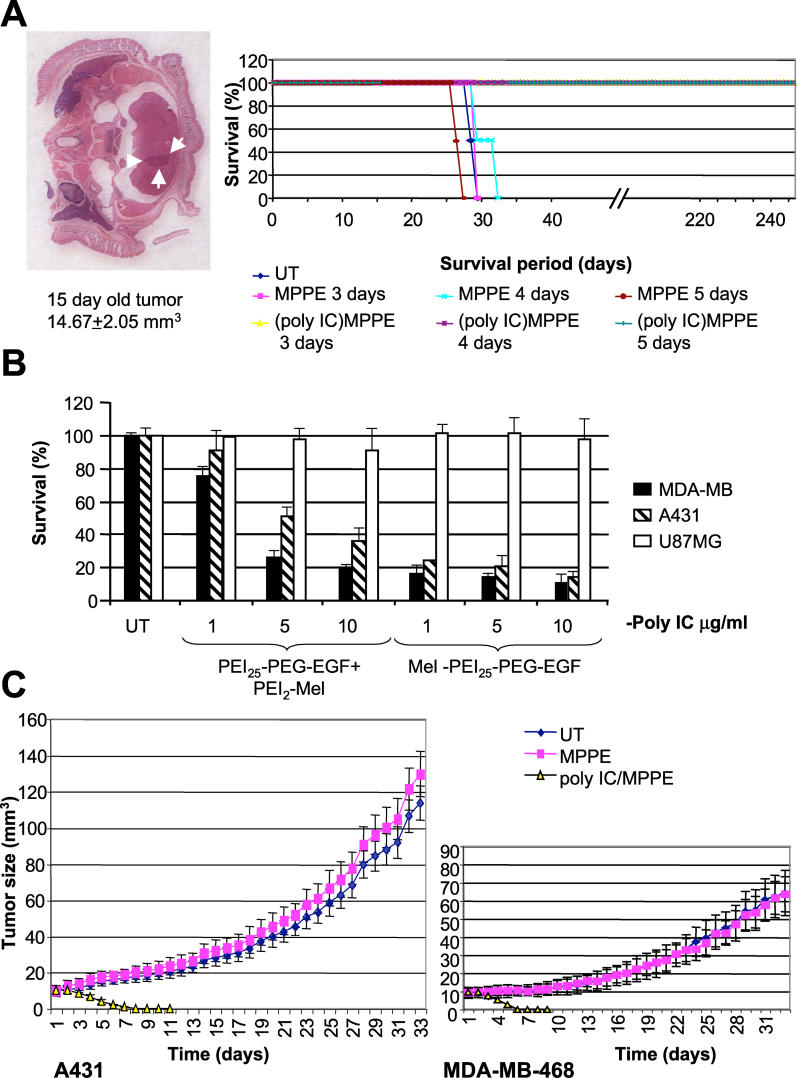
Targeted Poly IC Eliminates Three Types of EGFR Over-Expressing Tumors(A) (poly IC)Mel-PEI-PEG-EGF (MPPE) complexes prolong survival of mice bearing large intracranial U87MGwtEGFR xenografts. Cells were implanted into the brains of 16 mice. 15 d later, two animals were sacrificed to measure the tumors (Methods). Other animals received the indicated treatments. The daily doses of complexes were similar to the doses in Figure 3A and 3B. Survival of the animals was analyzed as above.(B) Formulated poly IC selectively kills A431 and MDA-MB-468 cells. Cells were seeded in duplicate onto a 96-well plate at a density of 5,000 cells in 0.2 ml of medium per well and grown overnight. Cells were then transfected as described [6,9] with poly IC at the indicated concentrations using either MPPE or PEI-PEG-EGF+PEI-Mel. Cell survival was measured by the Methylene blue assay at 48 h after transfection.(C) (poly IC)MPPE complexes eliminate A431 and MDA-MB-468 xenografts in mice. A431 and MDA-MB-468 tumors were established and treated with formulated poly IC as described in Methods. Tumors were measured daily. Control animals were euthanized at day 33 after treatment initiation. Poly IC treated mice were kept alive to detect possible late recurrence of the tumors.